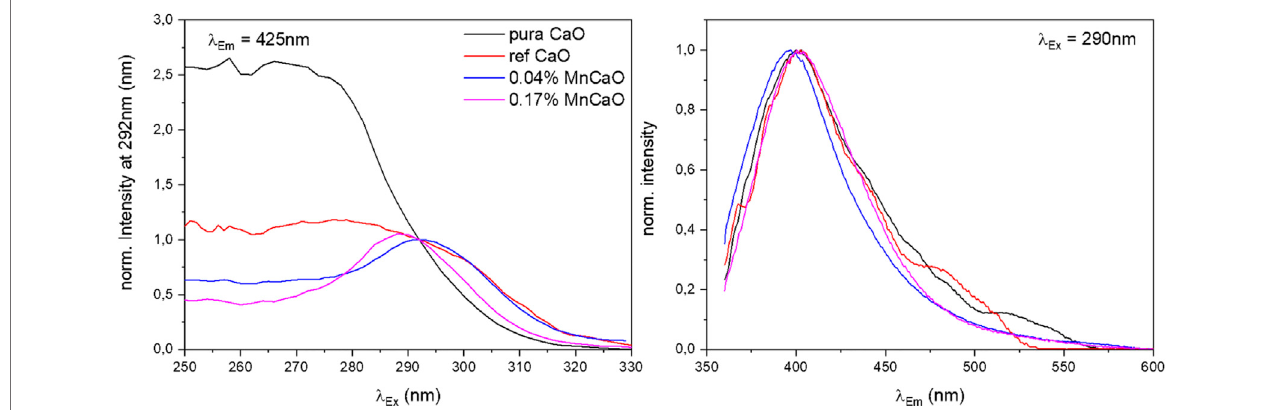
FIGURE 3 | Normalized excitation and emission spectra at λ Em = 425 nm and λ Ex = 290 nm of pure CaO and Mn-doped CaO samples under vacuum.